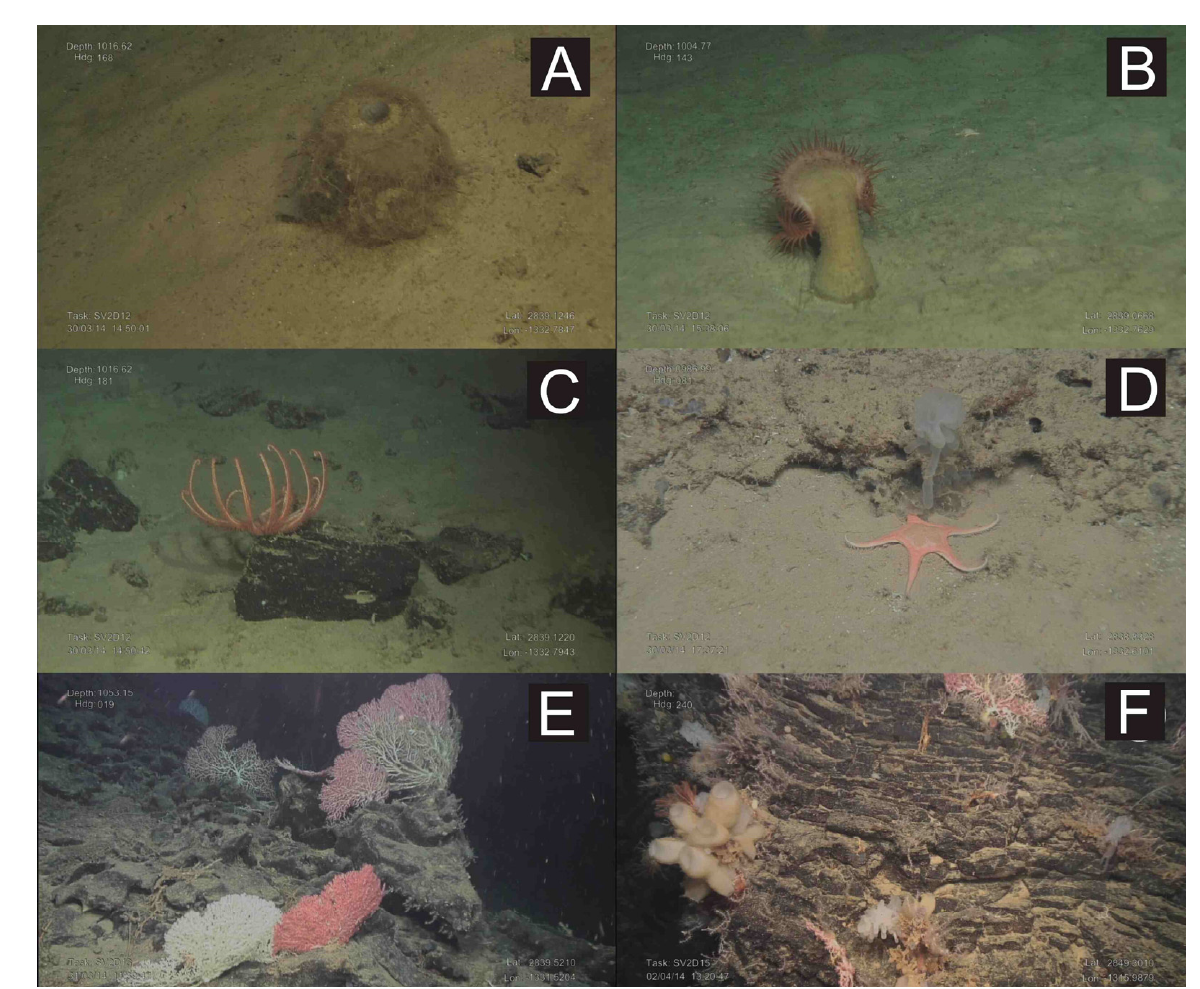
Figure 8. Underwater images obtained with the ROV “Luso”during the SUBVENT- 2 expedition along the PoL. ( A ): The hexactinellid sponge Pheronema carpenteri on soft substrates of the northern flank of M1 mound; ( B ): A Venus fly-trap anemone on soft substrates of the northern flank of M1 mound; ( C ): Brissingid starfishes colonizing small volcanic rocks at the summit of M1 mound; ( D ): The starfish Nymphaster arenatus on volcanic rocks at the summit of M1 mound; ( E ): Large colonies of the stony octocorals Corallium spp. ( C. niobe and C. tricolor ) on basaltic rocks of the volcanic ridge located at the northeastern part of M1 mound; ( F ): Basaltic rock colonized by different glass sponges, octocorals ( Corallium , Swiftia ) and hydrozoans at the Volcancito Hill. See Figure 7 for